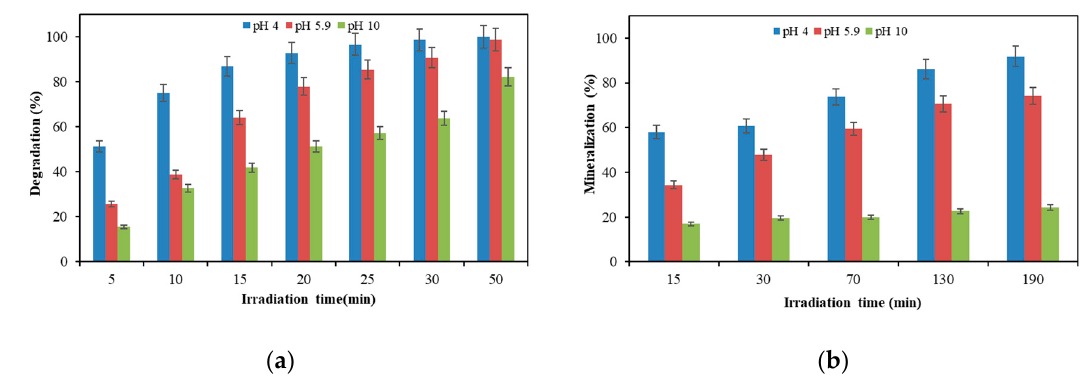
Figure 5. Effect of initial solution pH on the pollutant degradation ( a ) and mineralization ( b ) efficiency. Initial clofibric acid concentration of 1.5 mg/L, 1 g/L catalyst load, 9.52 mW/cm 2 , and room temperature.